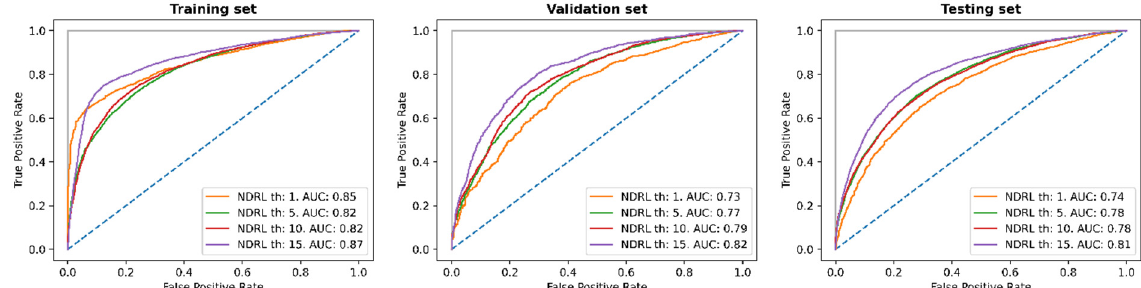
Figure 2. Receiver operating characteristic (ROC) curve for the testing, validation, and training set using 1, 5, 10, and 15 as thresholds for the NDRL. The blue dashed diagonal line represents how a random model would behave.